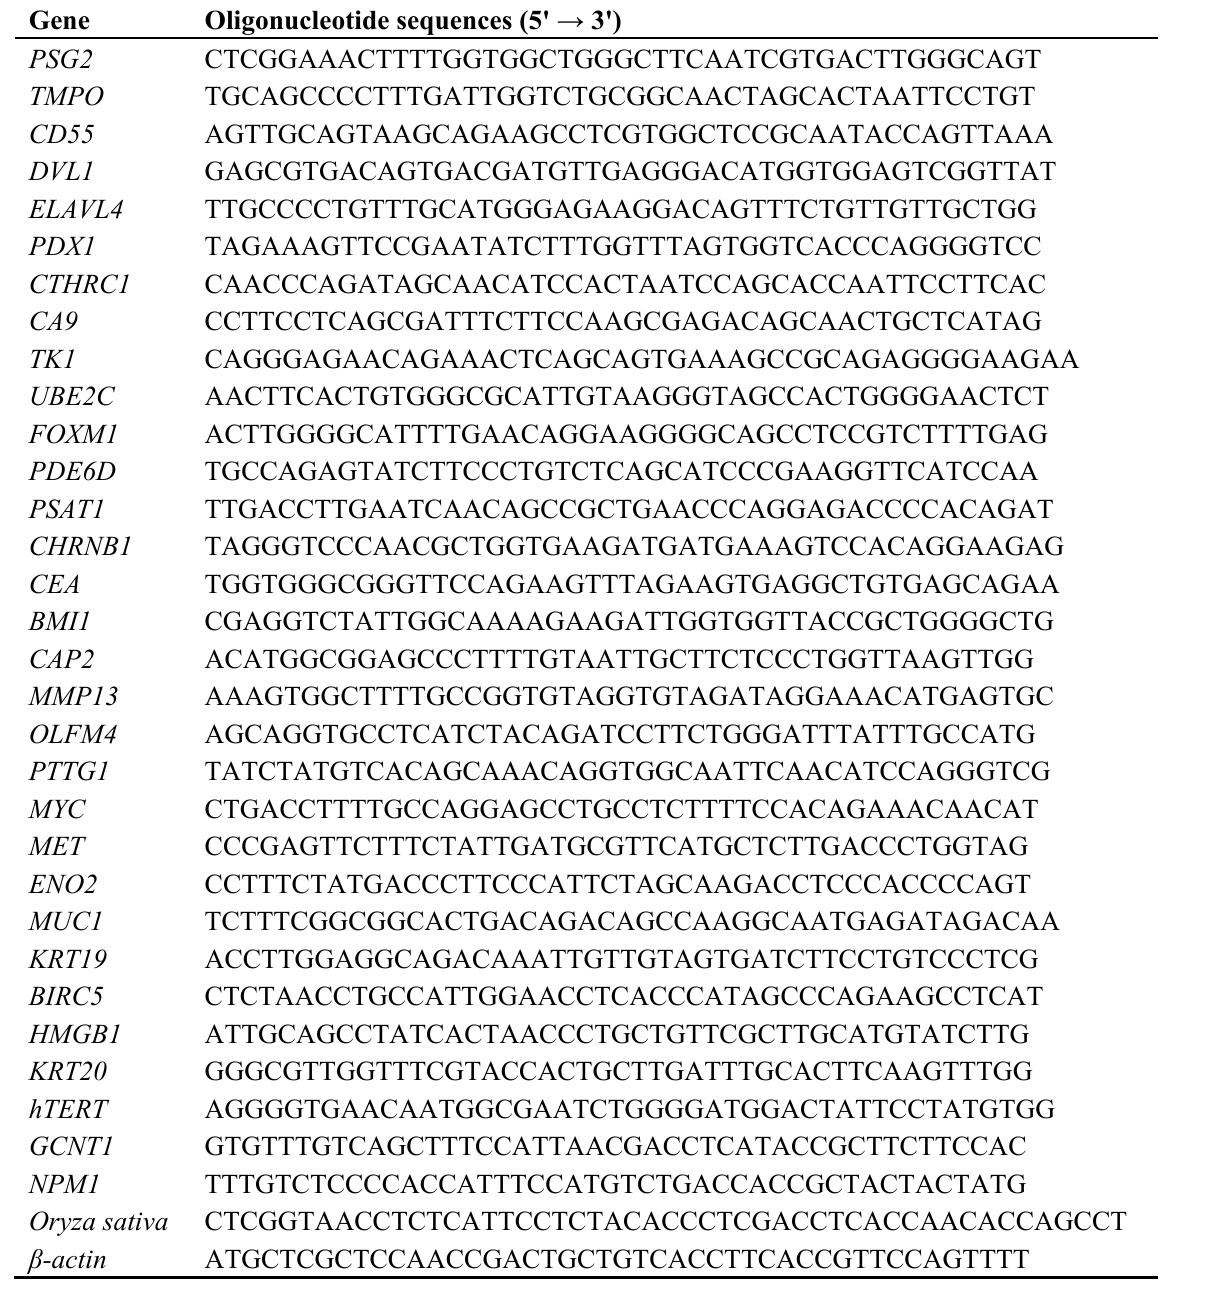
Table 1. Oligonucleotide sequences of 31 target